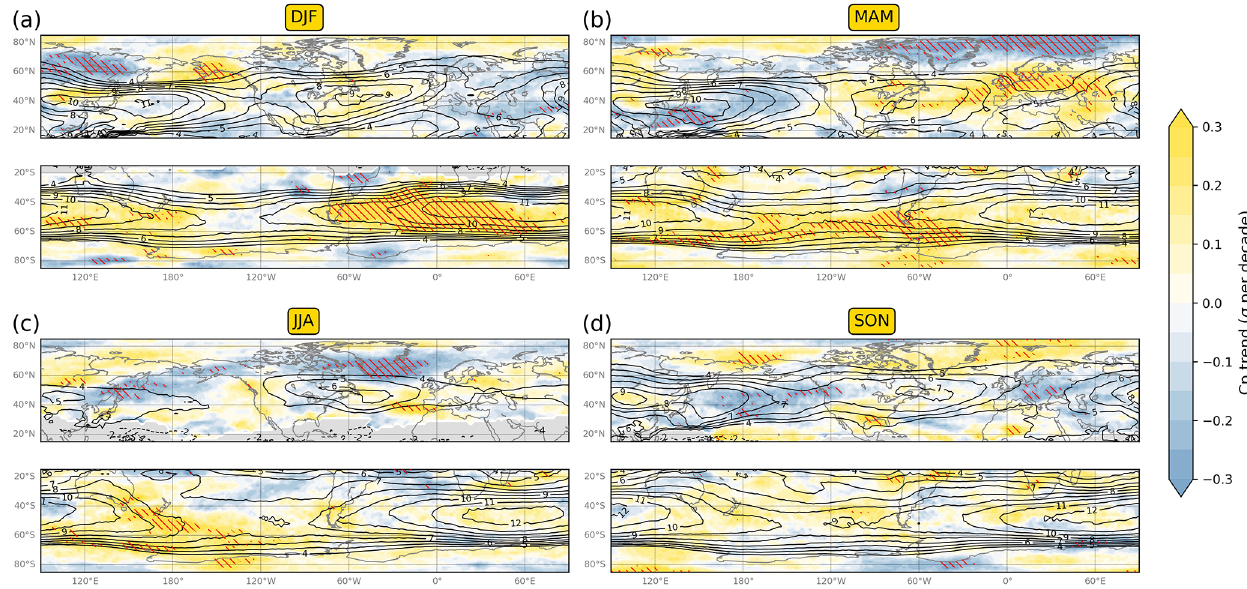
Figure 8. Same as Fig. 6, but for c p at 300hPa (solid and dashed black contours denote positive and negative climatological-mean values, respectively). As with the RWP phase index, grid points where the c p is undefined for more than 25% of the seasons are masked (grey